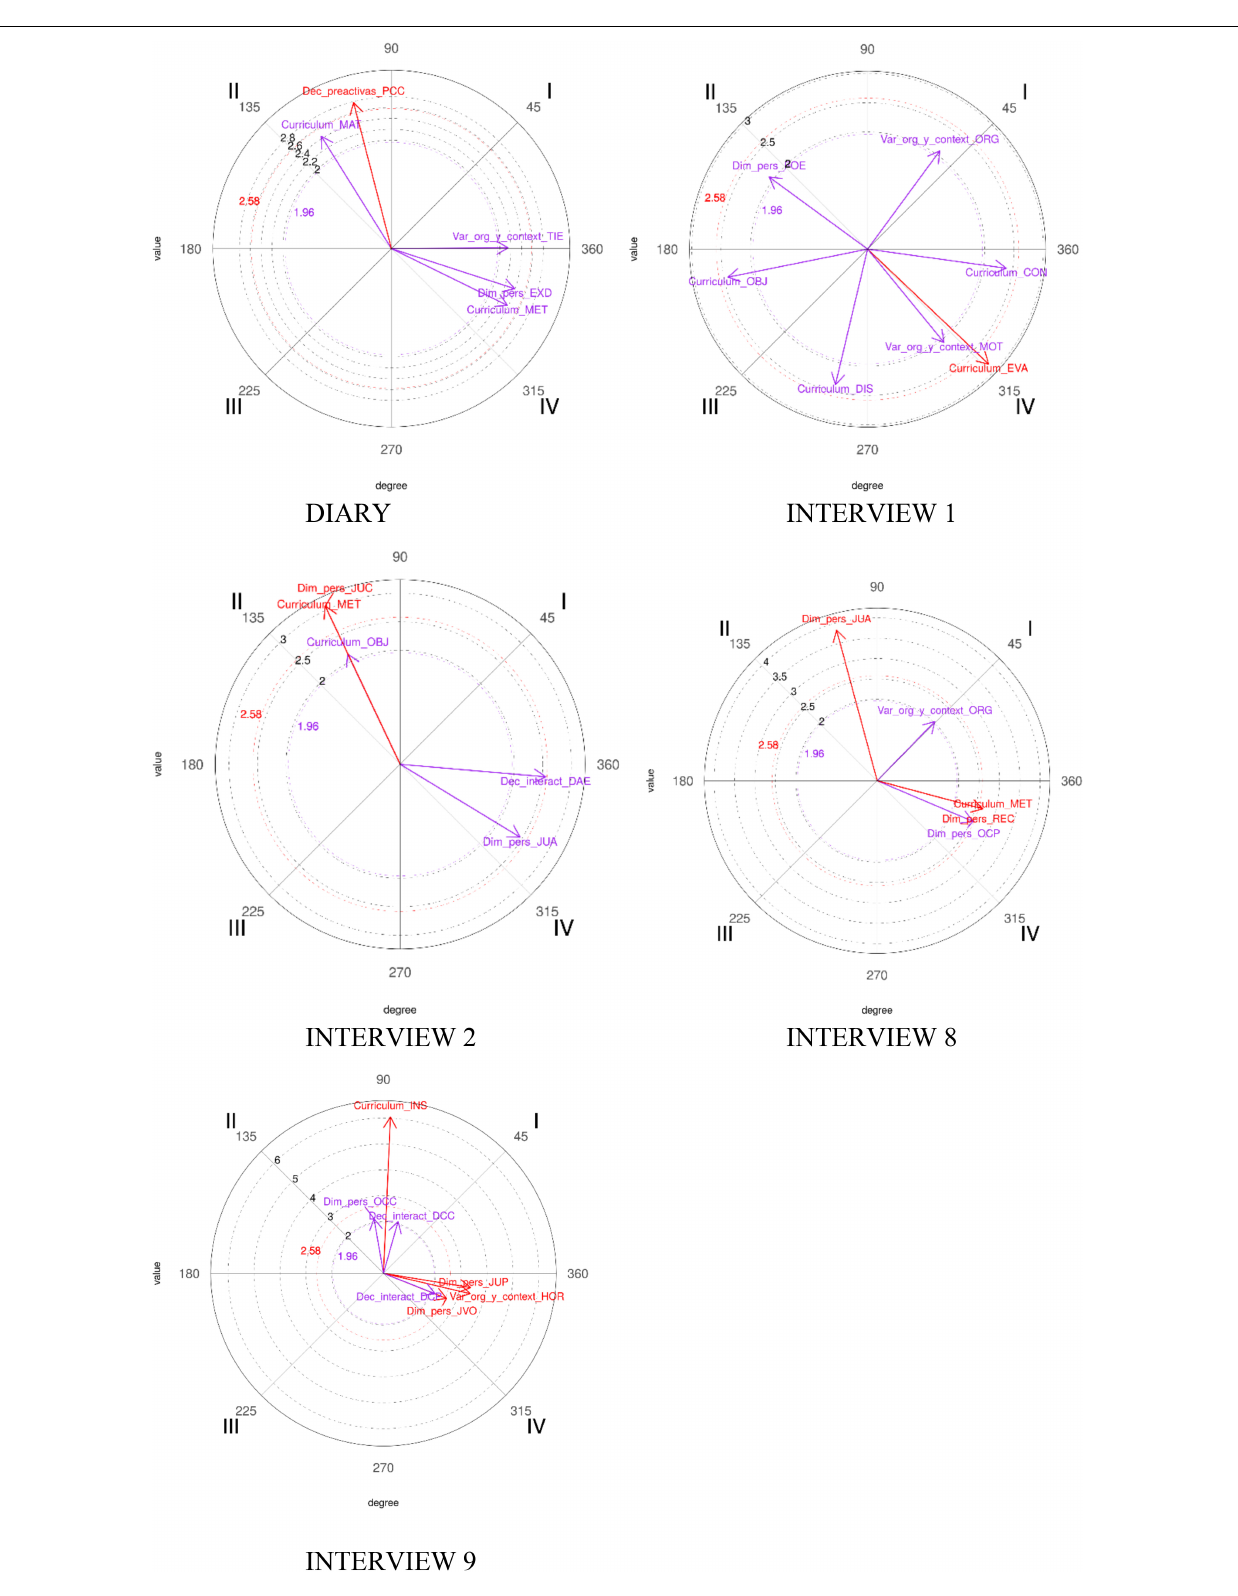
FIGURE 1 | Graphics showing the relationships between Joseph’s focal behavior (TAR) and conditional behaviors.